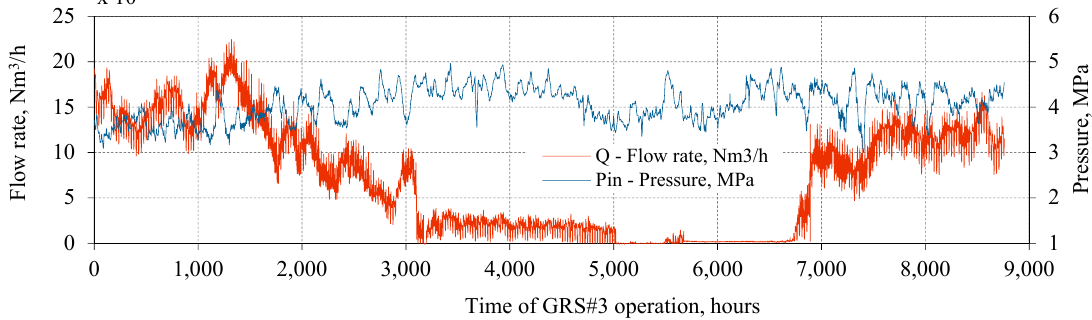
Figure 6. Natural gas flow and pressure at regulation stations GRS #3 (before expansion) over a period of one year.